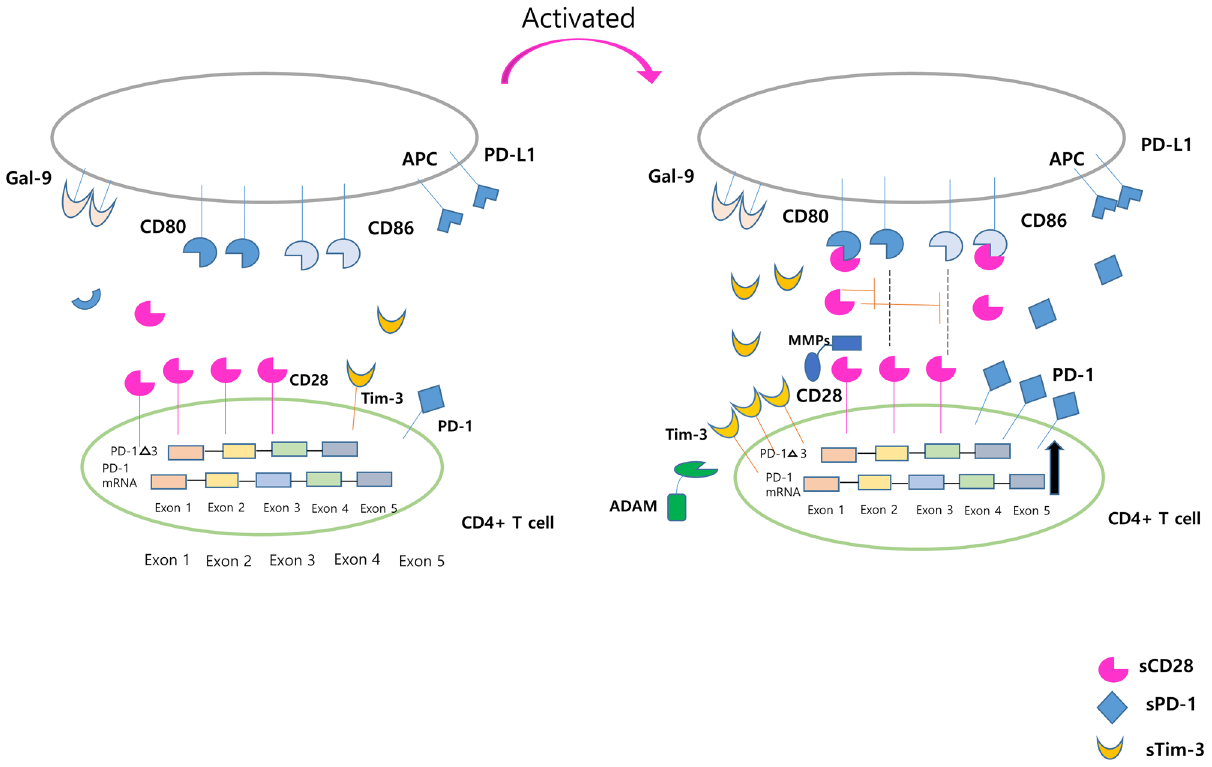
Figure 4. Schematic illustration of checkpoint molecule alteration in T cells by AAV activation. CD28 is proteolytically cleaved by MMP2 and MMP13 upon T-cell activation, resulting in the increased serum concentrations of sCD28 and decreased surface CD28 expression, and sCD28 acts as a decoy receptor. However, the production of inhibitory molecules, such as PD-1 and Tim-3, is induced by the persistent stimulation of T cell receptors. Consequentially, the serum concentration of sPD-1 produced by alternative splicing increases, and the serum levels of sTim-3 are increased by shedding by ADAM10 and 17. AAV ANCA-associated vasculitis, ANCA Antineutrophil cytoplasmic antibody, MMP Matrix metalloproteinases, PD Programmed cell death, Tim-3 T-cell immunoglobulin and mucin-domain containing-3, ADAM A disintegrin and metalloproteinase domain-containing protein, Gal-9 (Tim-3 ligand) Galectin-9, PD-L1 Programmed cell death